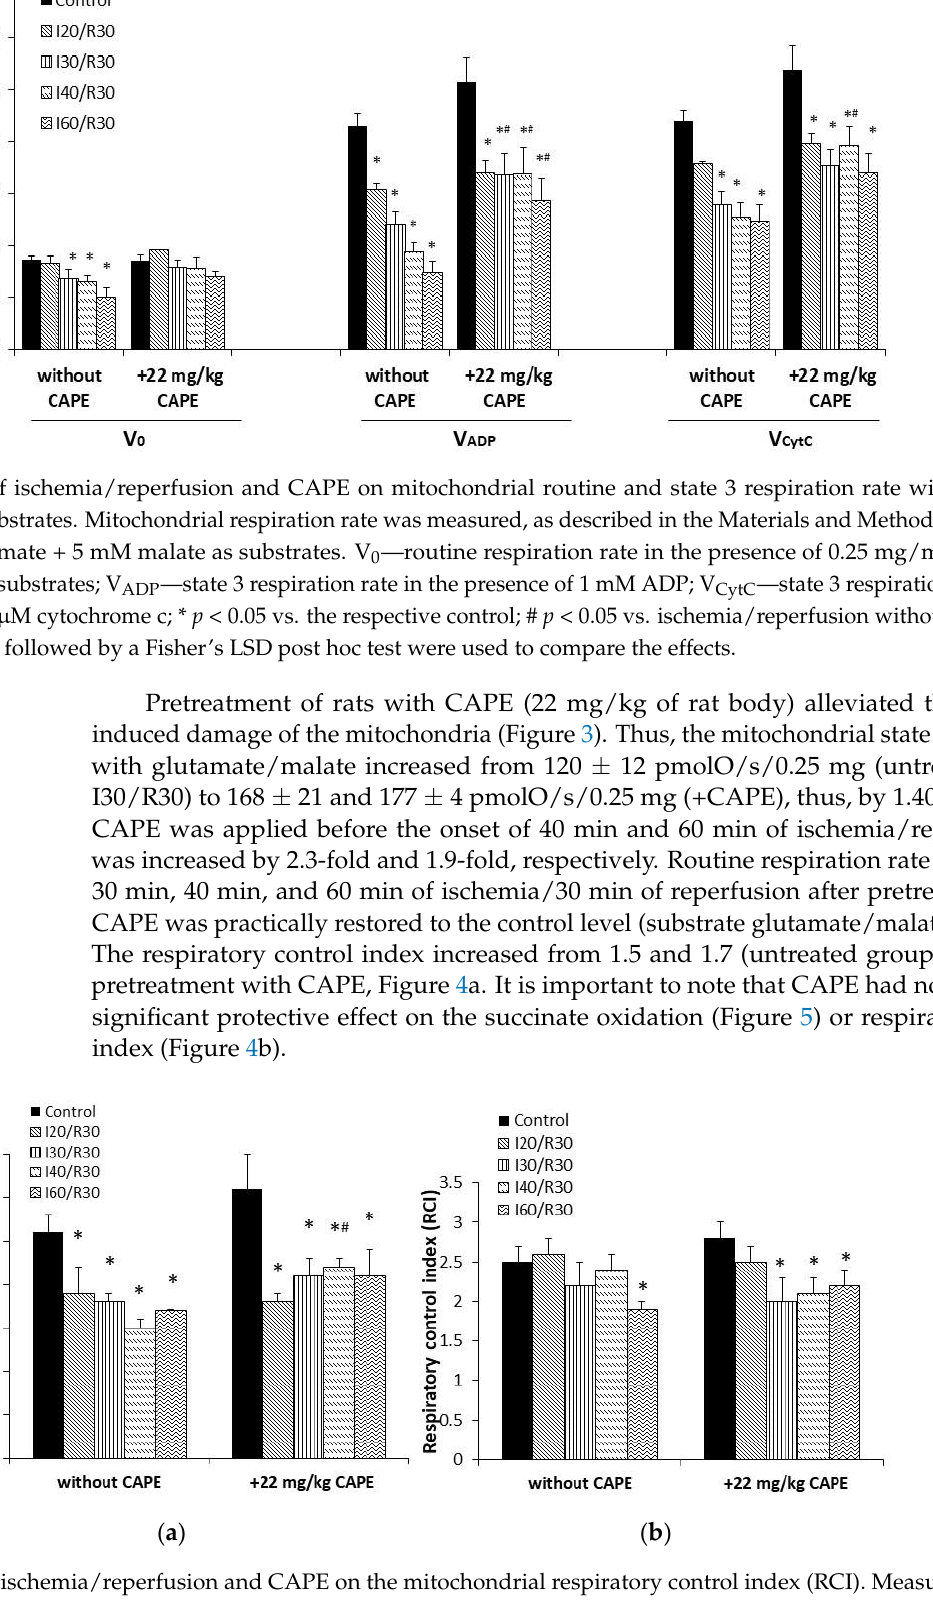
Figure 4. Effect of ischemia/reperfusion and CAPE on the mitochondrial respiratory control index (RCI). Measurements were performed in the presence of 5 mM glutamate + 5 mM malate ( a ) or 15 mM succinate (+50 nM rotenone) ( b ) as substrates. Mitochondrial respiratory control index (RCI) is taken as the ratio between the oxygen uptake rates in state 3 and the routine respiration rate (RCI = V 3 /V 0 ). Each column represents the mean ± SEM of four independent experiments; * p < 0.05 vs. the respective control; # p < 0.05 vs. ischemia/reperfusion without CAPE. One-way ANOVA followed by a Fisher’s LSD post hoc test were used to compare the effects. Figure 5. Effect of ischemia/reperfusion and CAPE on the kidney mitochondrial routine and state 3 respiration rate with succinate as a substrate. Mitochondrial respiration rate was measured, as de- scribed in the Materials and Methods section, using 15 mM succinate (+50 nM rotenone) as a sub- strate. V 0 — routine respiration rate in the presence of 0.25 mg/mL of mitochondria and substrate; V ADP — state 3 respiration rate in the presence of 1 mM ADP; V CytC — state 3 respiration rate in the presence of 32 µM cytochrome c, * p < 0.05 vs. the respective control. One-way ANOVA followed by a Fisher ’s LSD post hoc test were used to compare the effects. Moreover, the cytochrome c effect obviously increased due to ischemia/reperfusion damage; however, it was clearly reduced after pretreatment with CAPE (for comparison, cytochrome c effect (substrate glutamate/malate) after ischemia/reperfusion varied be- tween 1.20 – 1.70-fold), whereas after pretreatment with CAPE, it decreased to 1.0 – 1.2-fold (Figure 6a). Analyzing succinate oxidation, the cytochrome c effect after 30 – 60 min of ischemia /reperfusion varied between 1.5 – 2.2-fold, whereas after pretreatment with CAPE, it decreased to 1.3 – 1.6-fold (Figure 6b).